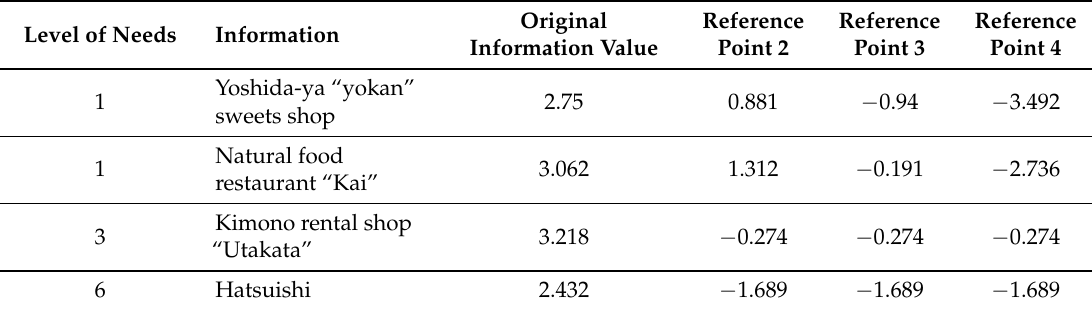
Table 12. Information value at reference points 2, 3, and 4.